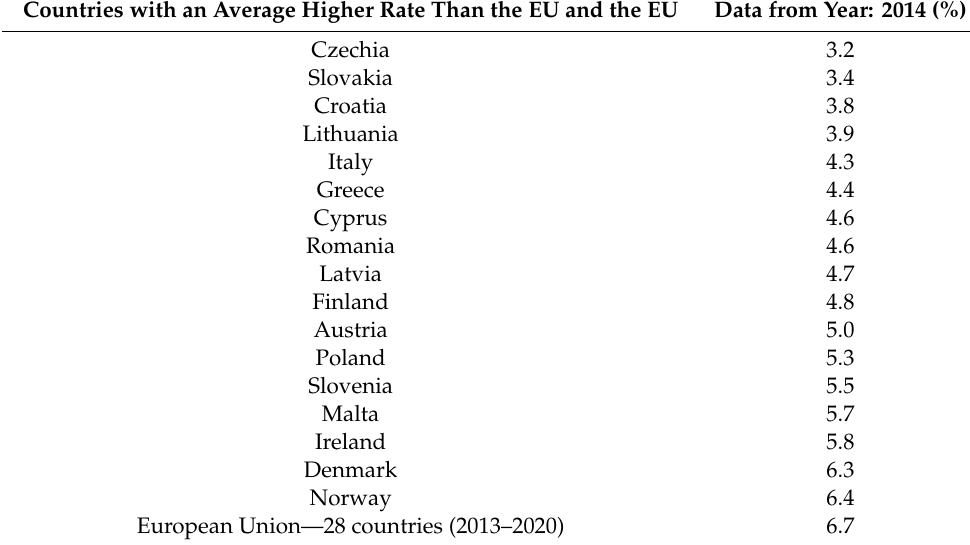
Table A6. Current depressive symptoms (Eurostat